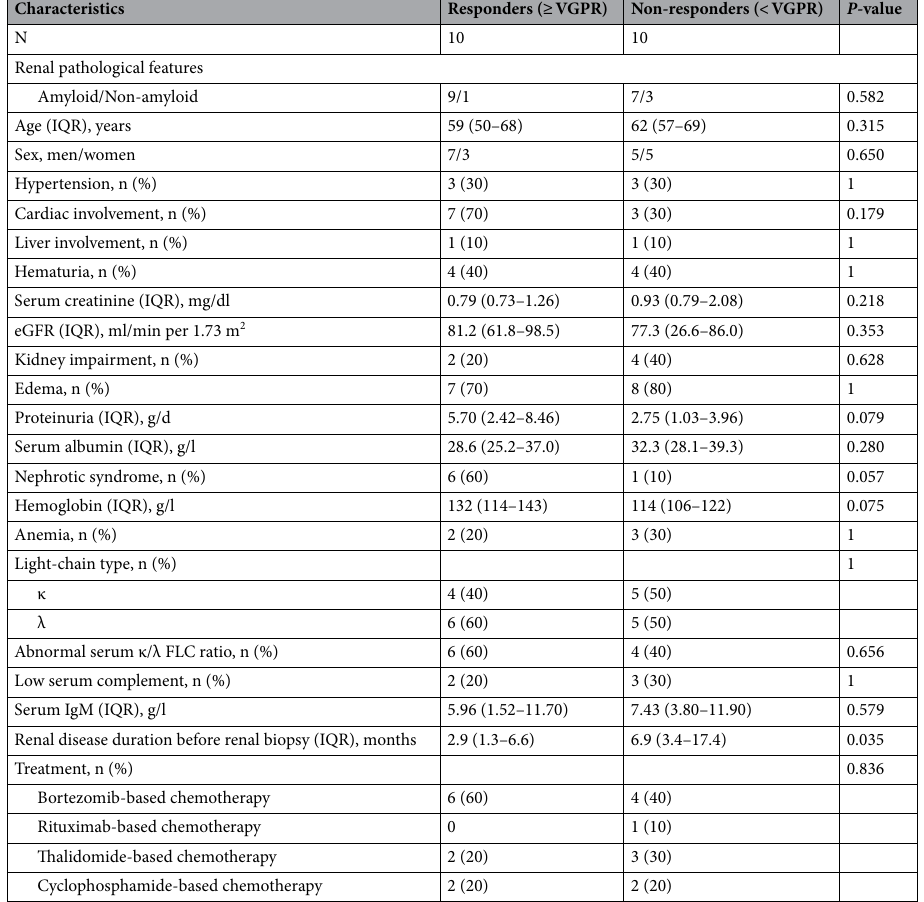
Table 3. Compared baseline characteristics and treatment of responders (≥ VGPR) and non-responders (< VGPR).